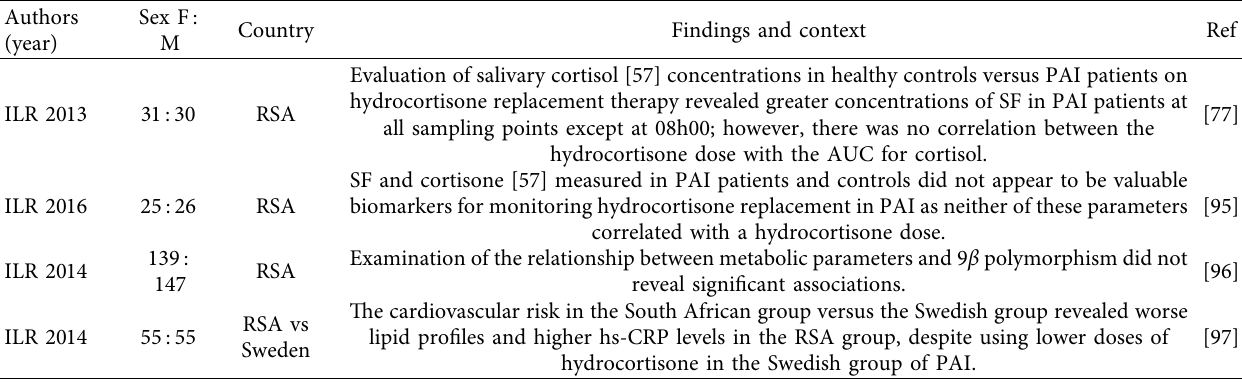
Table 2: A summary of cohort studies on the management and monitoring of adrenal insufficiency (PAI) reported from Africa.